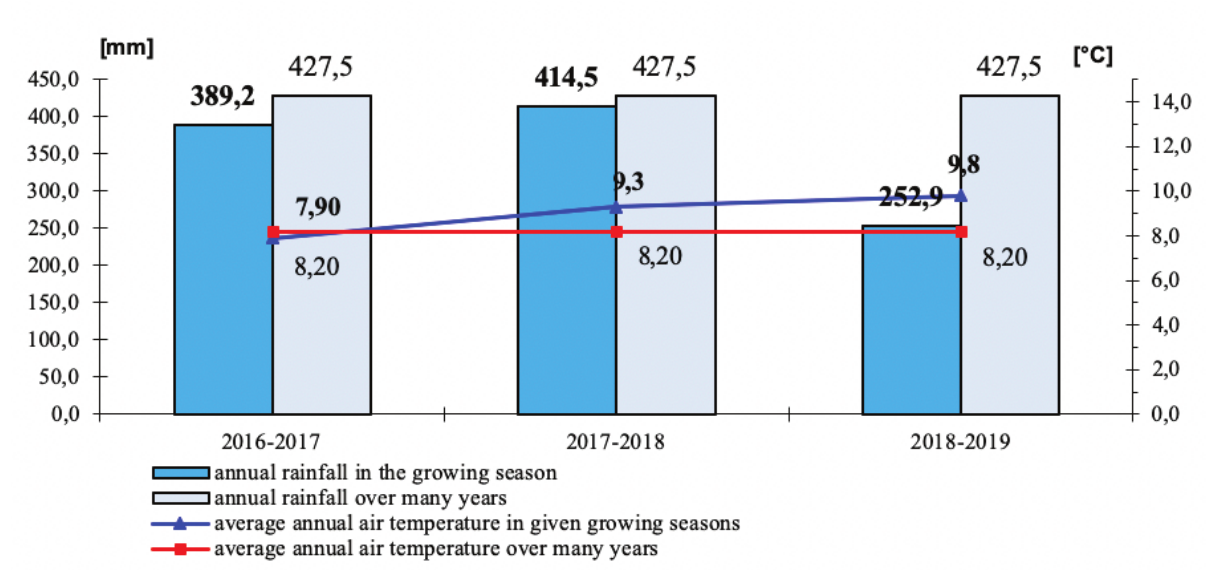
Figure 1: Monthly precipitation sums and average air temperature in given growing seasons RSD Zawady of many years (1996-2010)